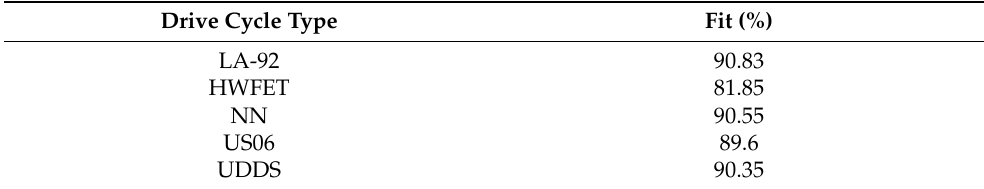
Table 3. Performance of the model (BJ7) in terms of goodness of fit for different driving cycles.